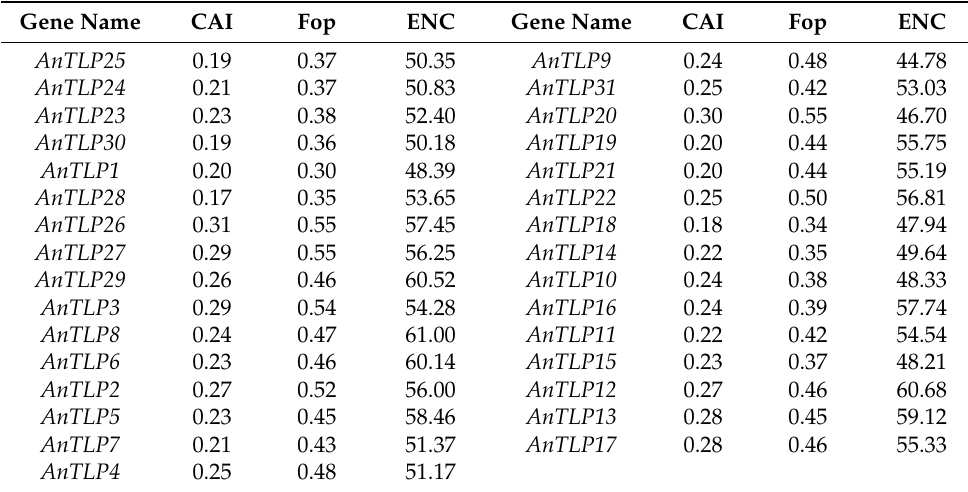
Table 3. Analysis of the codon usage bias of the A. nanus TLP gene